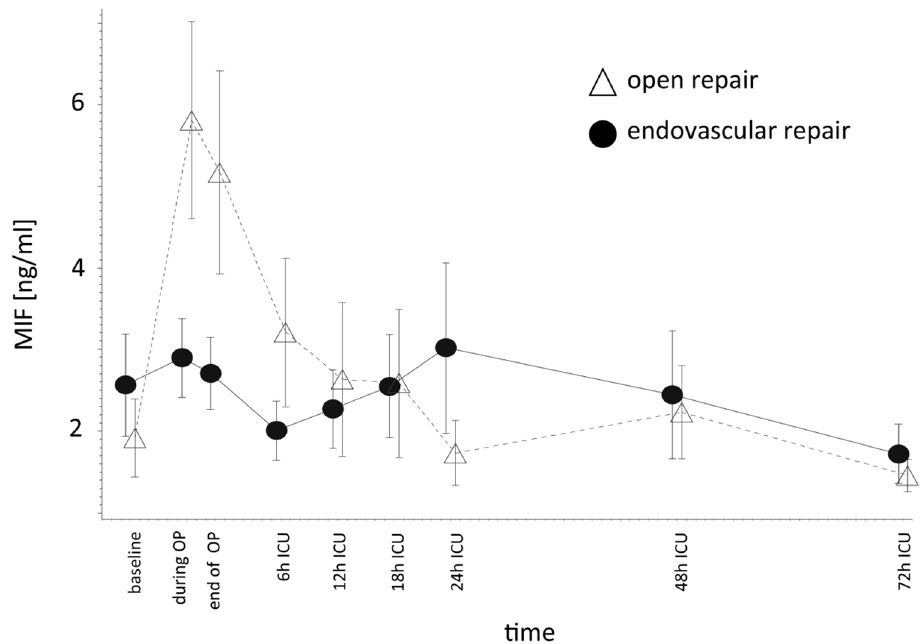
Figure 1. Macrophage migration inhibitory factor (MIF) release during aortic surgery. Compared to endovascular repair, the open procedure induced higher perioperative MIF release, and this difference persisted up to the first hours after intensive care unit (ICU) admission. Endovascular repair induced only a moderate perioperative MIF increase; MIF values are presented as median with interquartile range (ng/mL).